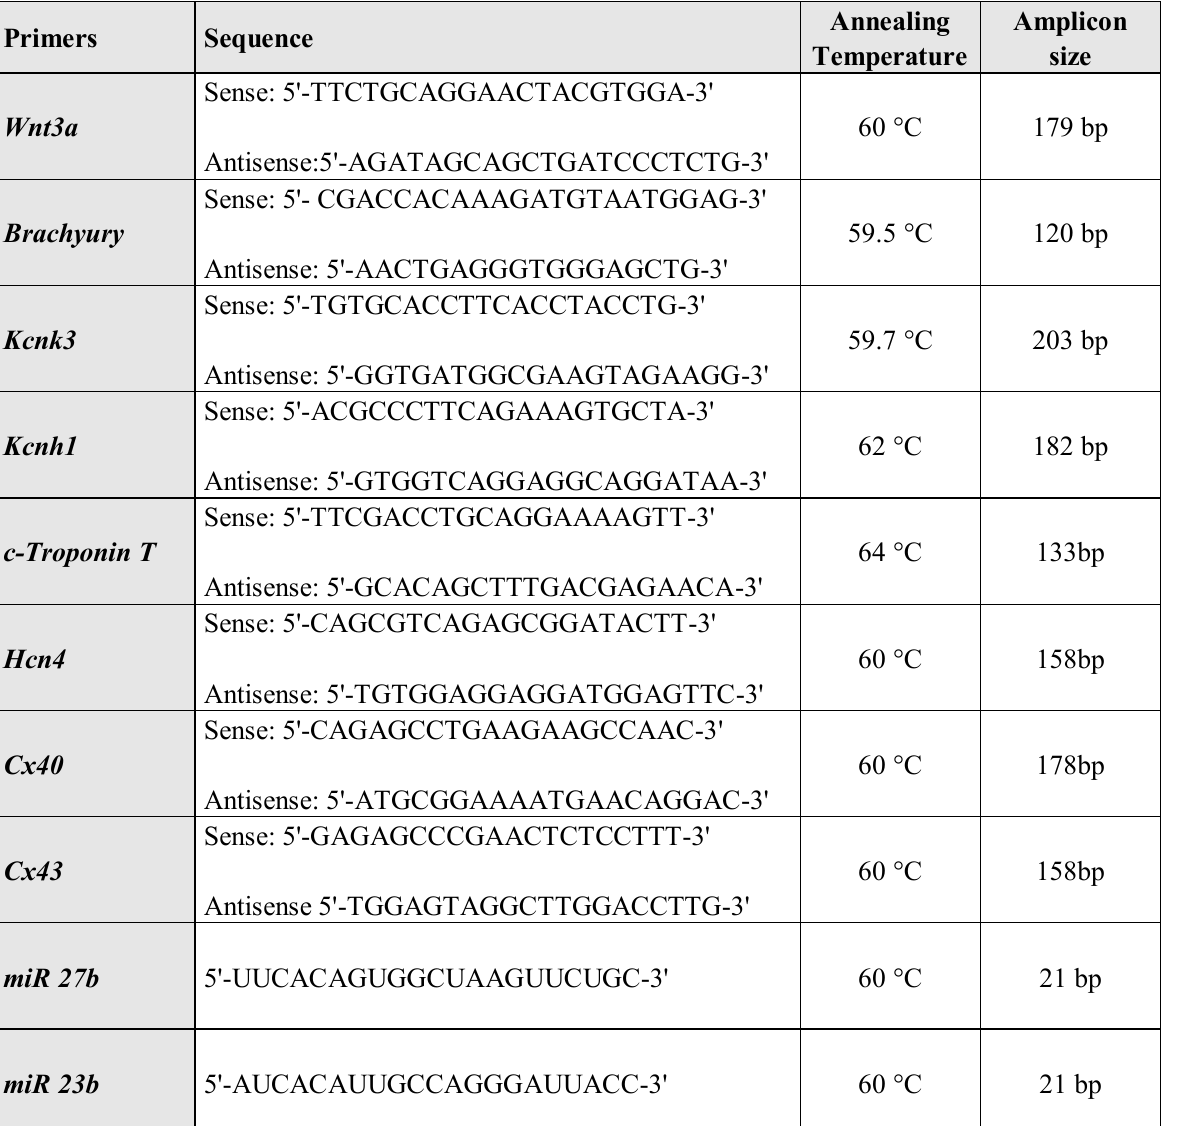
Table 1. Gene-specific primers, annealing temperatures, and amplicon sizes for quantitative Real-Time